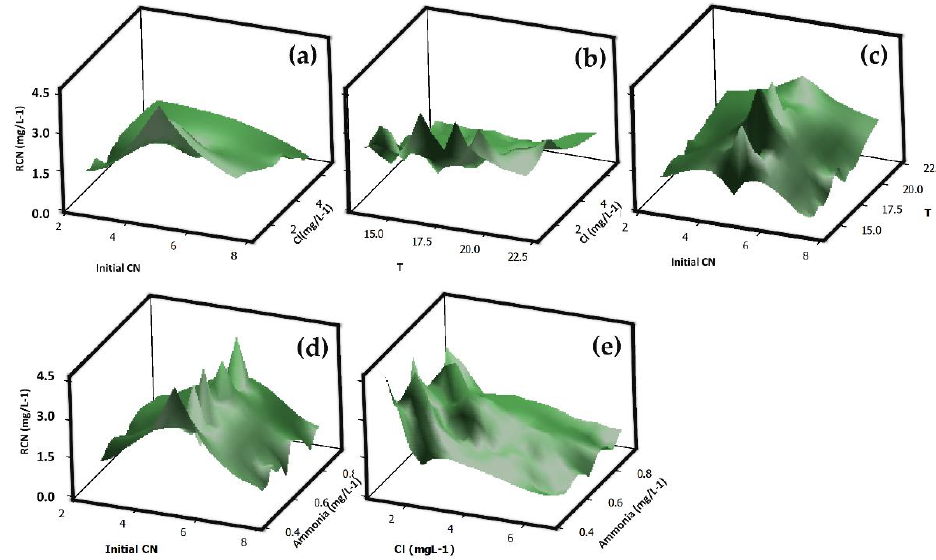
Figure 11. Sensitive analysis of the most important factors on RCN in the present research.